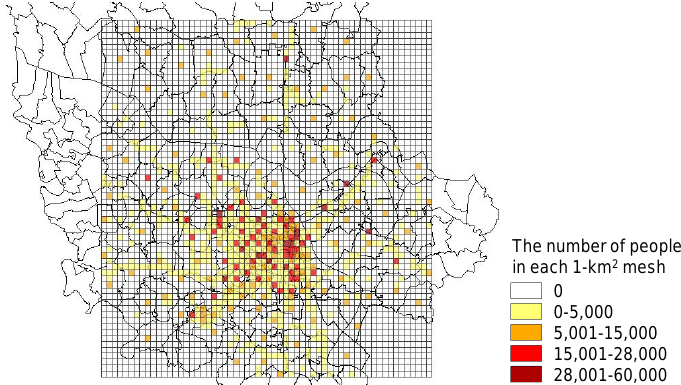
Figure 1. Problem of simple geocoding to the centroid of PTS